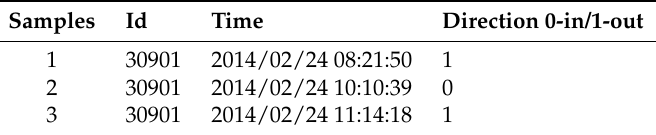
Table 4. Samples of the dormitory open/close